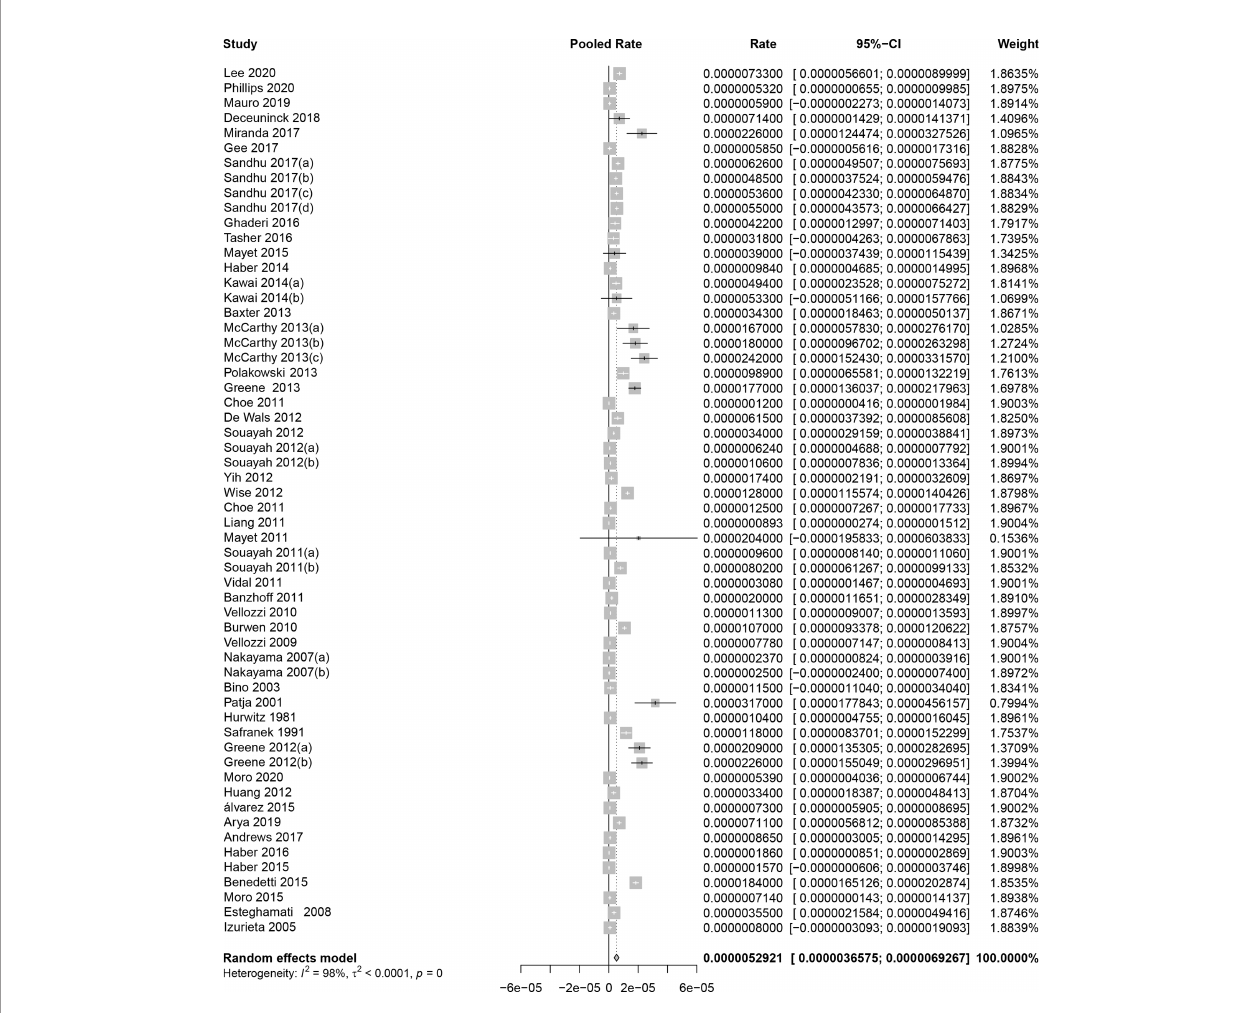
FIGURE 2 | Pooled background rates of Guillain-Barre ́ syndrome during mass immunization. CI, con fi dence interval.